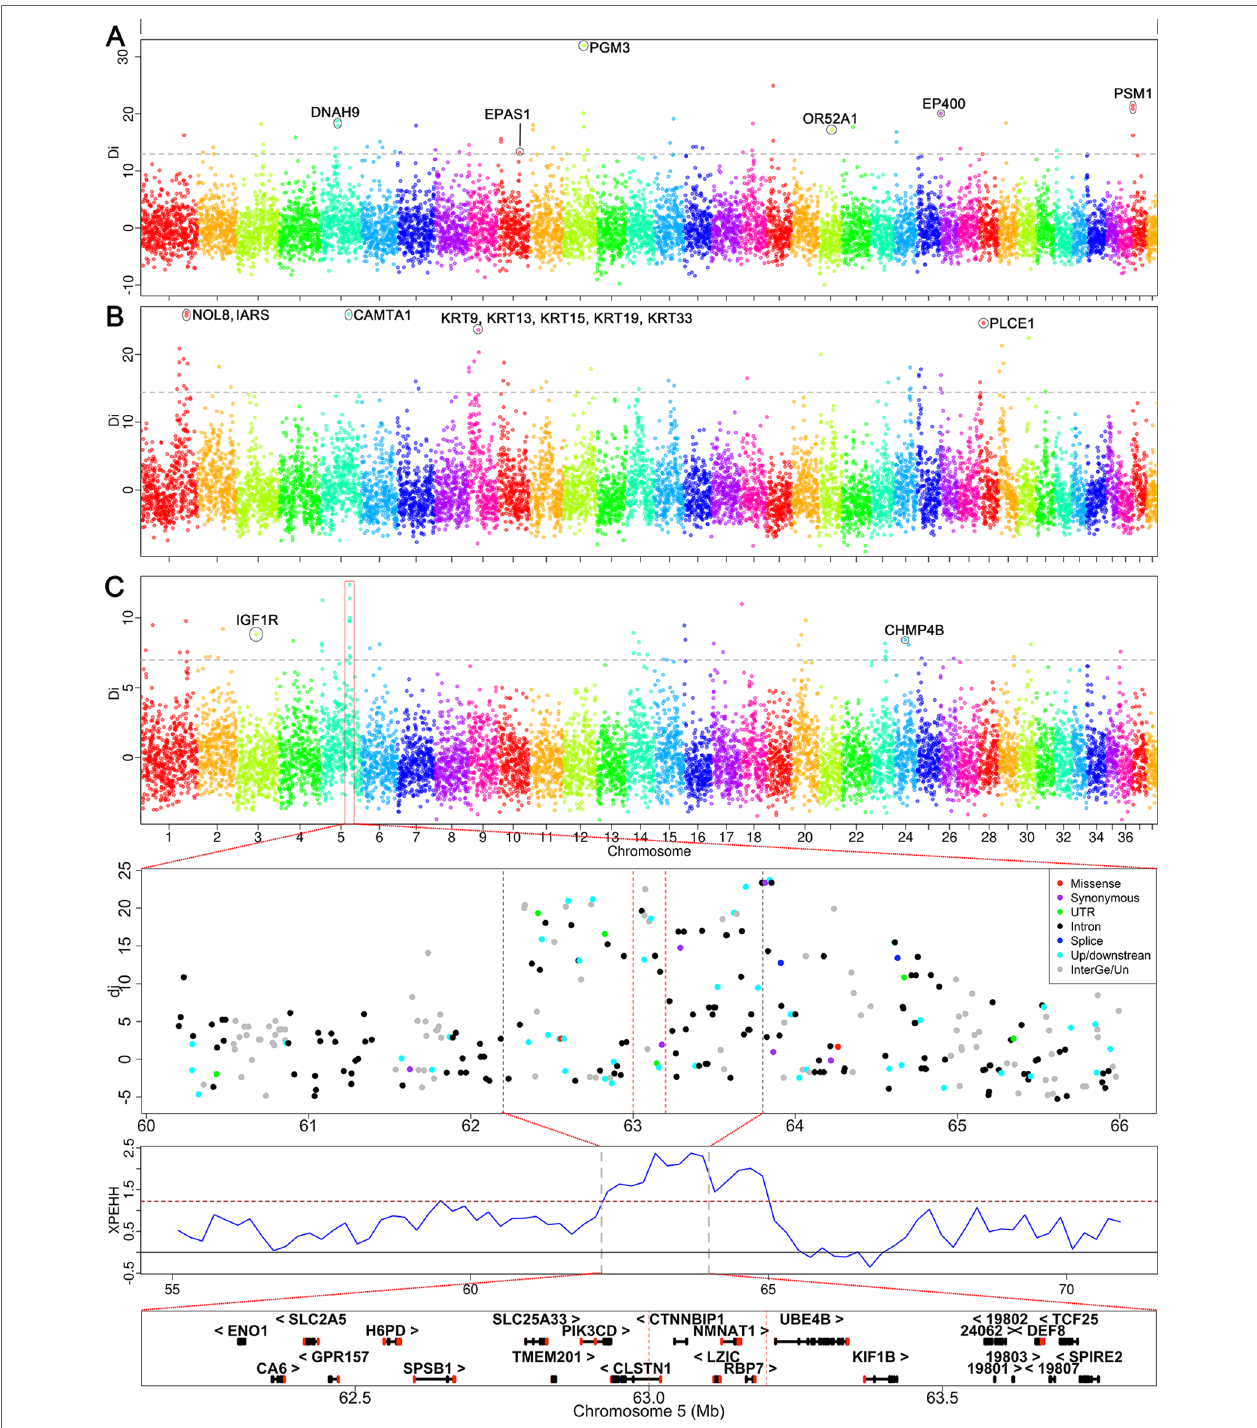
FIGURe 4 | Genome-wide scan for selection signatures in three specific dog groups. The y-axis shows the d i values of allele frequency difference between the tested group and the control. The analysis was performed using the d i statistics. The d i values were calculated for autosomal SNPs in 200-kb windows. The grey dash represents the threshold of 99.5 th percent signal level in whole-genome. (a) Selection signatures identified in Qinghai-Tibetan Plateau dogs. (B) The signals of selection sweep identified in Xi dogs. (C) The selection signals detected in mountain hounds. The strongest signal was identified on the CFA 5, where the regional overview of selection signatures and candidate genes are shown below panel 4C. The dashed lines indicate the core